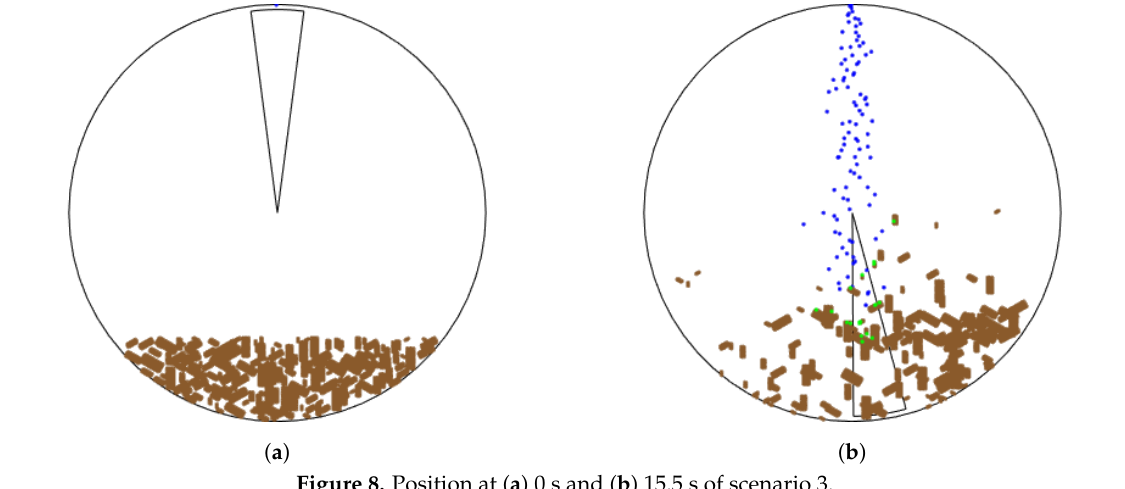
Figure 8. Position at ( a ) 0 s and ( b ) 15.5 s of scenario 3.